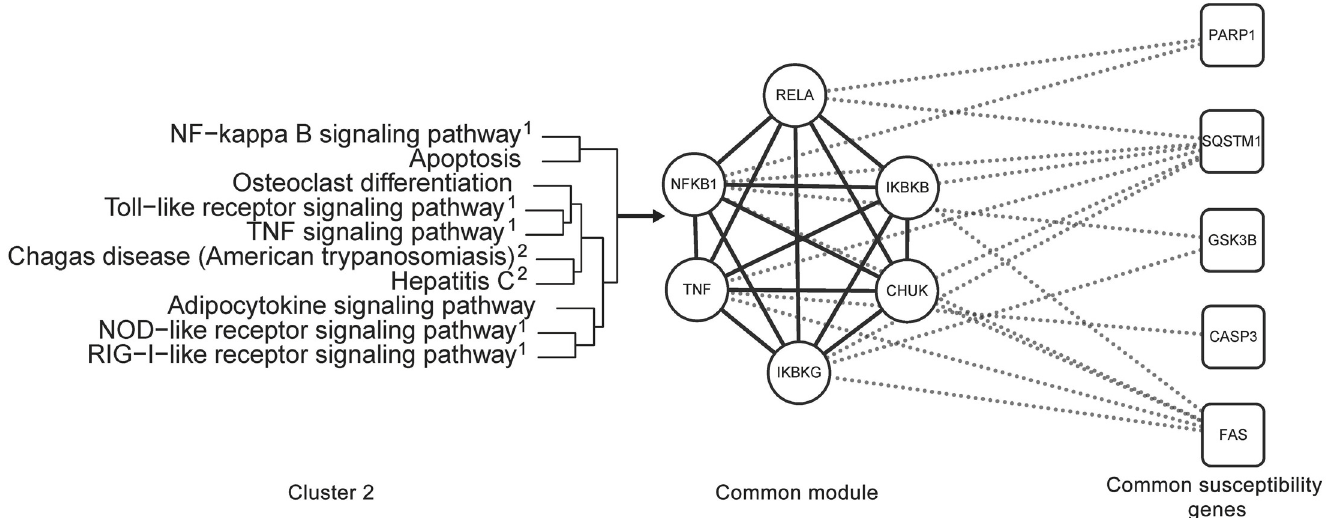
Fig 7. The common module from cluster 2. Their relationship with common susceptibility genes of AD, PD and HD is depicted. Module inner interactions are labeled by solid line, its relationship with susceptibility genes by dashed line. Gene names are marked on the nodes. 1 : pathways related to inflammation, 2 : pathways involved in infectious